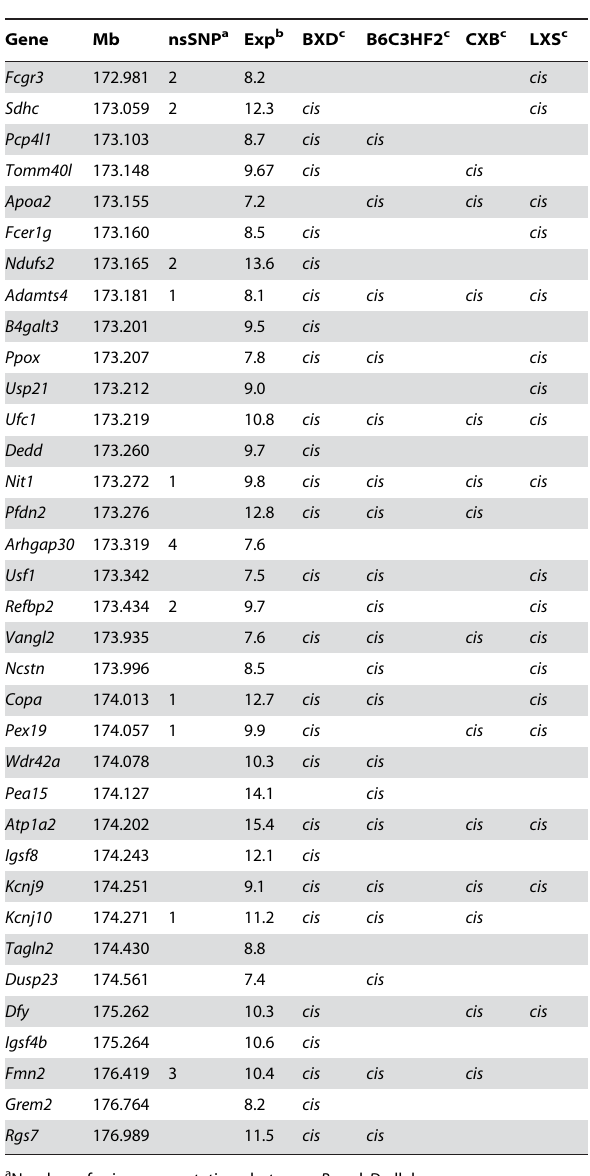
Table 3. Candidate genes in Qrr1 .